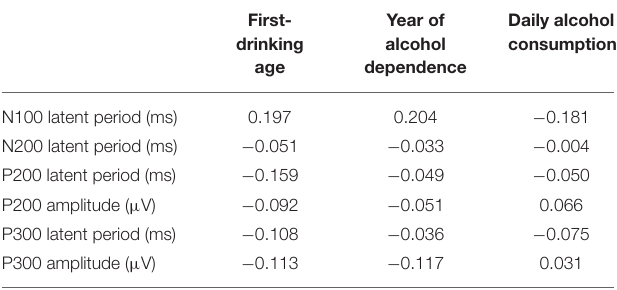
TABLE 5 | Analysis of the correlation between the first-drinking age, year of alcohol dependence, daily alcohol consumption, and ERPs in the alcohol-dependence